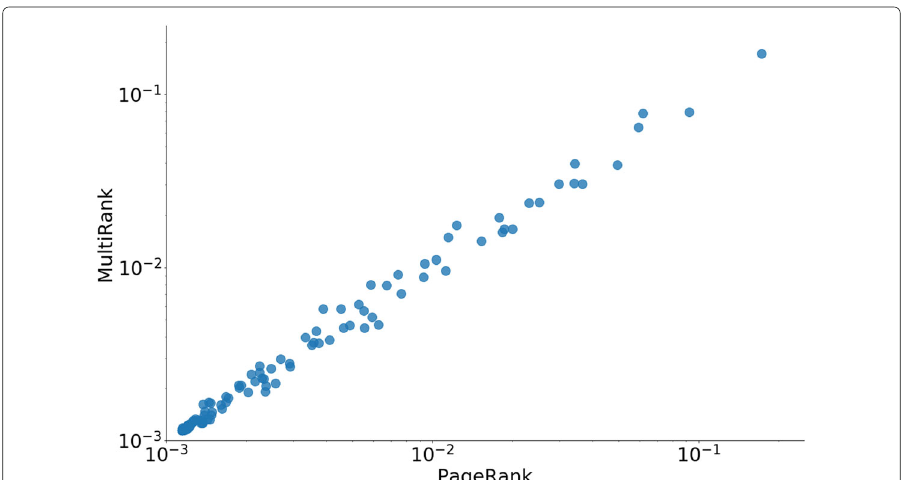
Fig. 9 Scatter plot of MultiRank scores versus PageRank scores for the global financial network in 2018. As we mentioned in the main manuscript, the MultiRank and PageRank scores are strongly